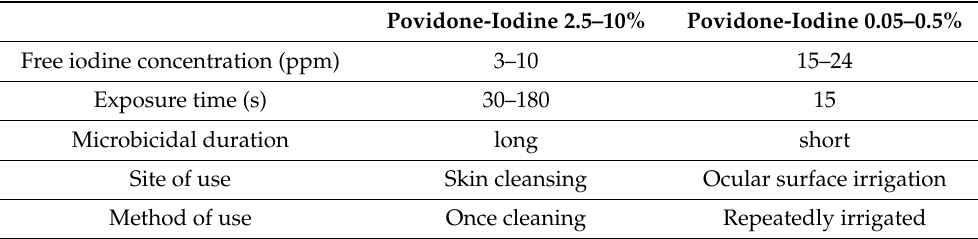
Figure 6. Concentrations of povidone-iodine, effective iodine concentration and exposure time required to obtain microbicidal effect. 0.1% povidone-iodine has free iodine concentration of 24 ppm with the greatest bactericidal effect, and the time required for microbial killing is as short as 15 s. When used to irrigate the ocular surface, 0.25% povidone-iodine is diluted approximately 2.5-fold to 0.1%. (Authors’ unpublished images). Table 2. Microbicidal features and sites and methods of use for high and low concentrations of povidone-iodine.